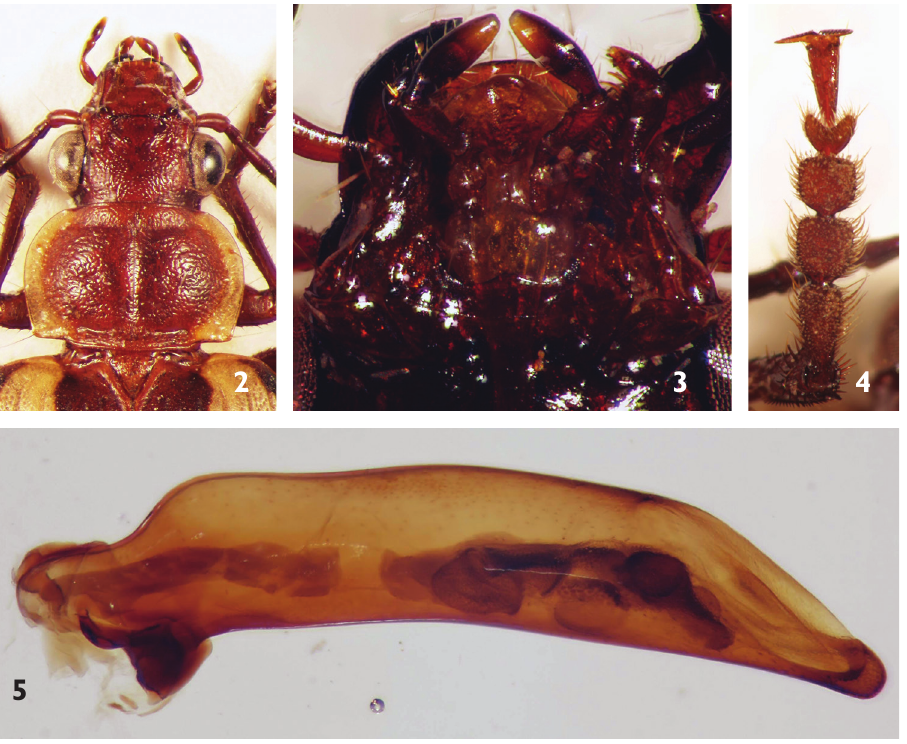
Figures 2–5. Lebistina rehagei sp. n. 2 head and pronotum (female) 3 head, lower side (male) 4 protarsus, lower side (male) 5 median lobe of